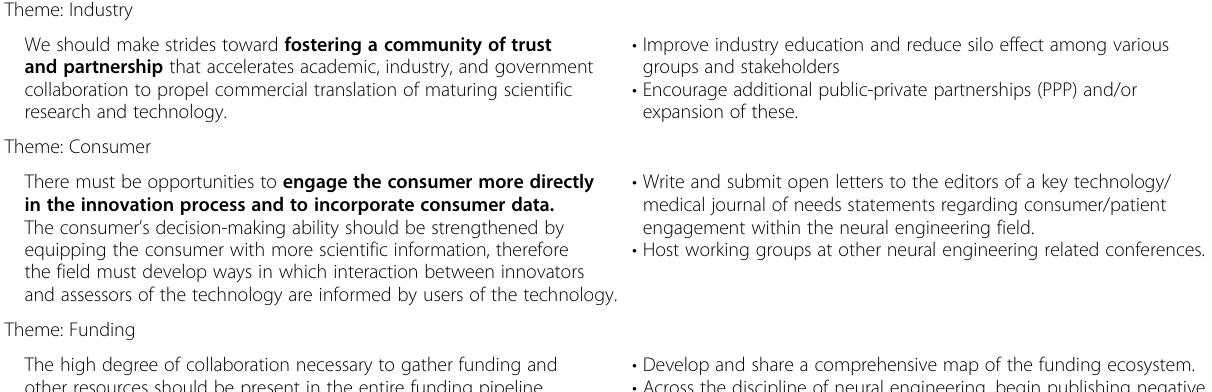
Table 1 Summary of vision and goals for each theme in the Cleveland Neural Engineering Workshop 2017 meeting Vision